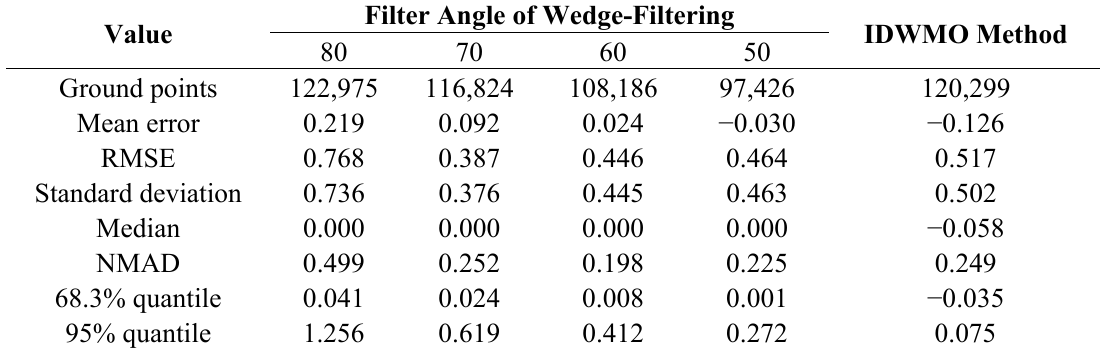
Table 4. Statistical values for the second test